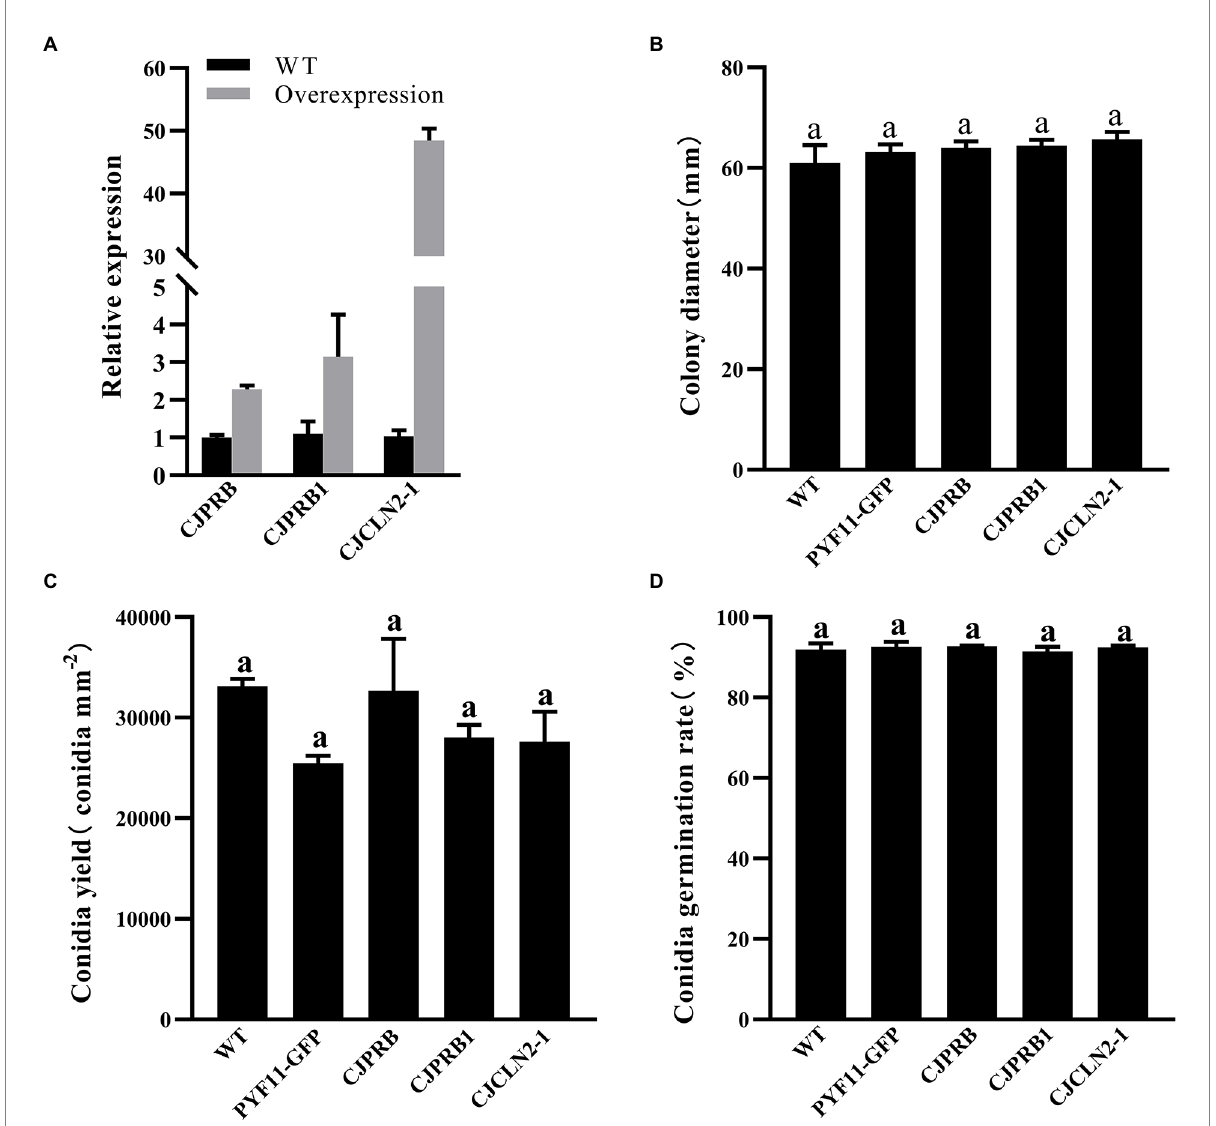
FIGURE 3 qRT–PCR and phenotype verification of CJPRB-, CJPRB1-, and CJCLN2-1-overexpressing BE01 strains. (A) Validation of overexpression strains by qRT–PCR. (B–D) Colony diameter, conidial production, and conidial germination rate of wild-type, PYF11-GFP-transformed, and overexpression strains of BE01 (mean ± SE). A common lowercase letter above the error bar is not significantly different ( p >0.05, Duncan’s multiple range